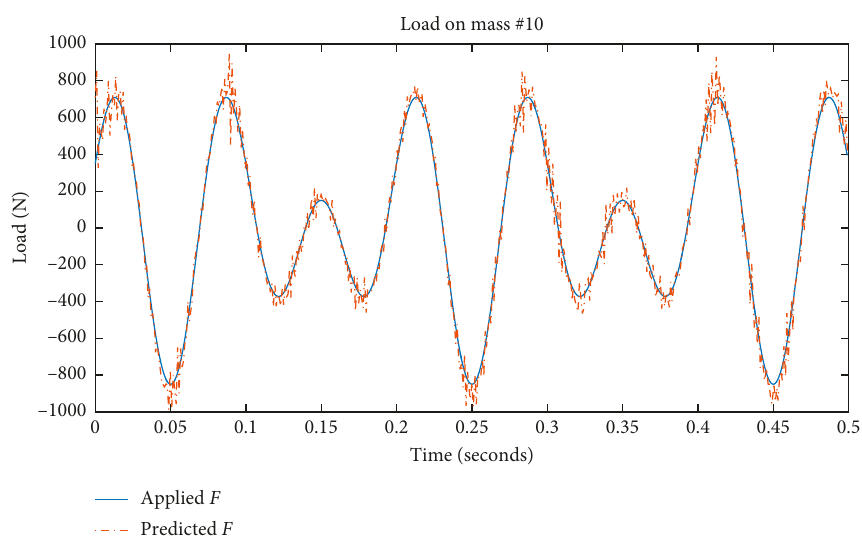
Figure 11: Applied and reconstructed load at mass 10 with measurement